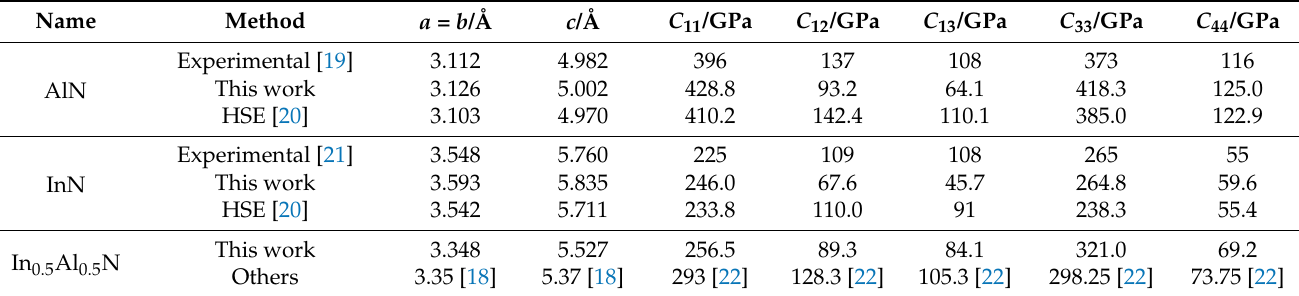
Table 1. Lattice parameters and elastic constants of AlN, InN, and In 0.5 Al 0.5 N.